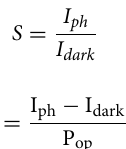
films, the value of the dark current and the photocurrent of ZnO thin films annealed by using the furnace and IR lamp gradually increased during repetitive on and off cycles with the UV light, indicating the poor reproduc- ibility of the photocurrent. The mechanism for the photocurrent rise and decay from the ZnO thin films is as follows. When the ZnO thin film-based UV photodetector is exposed to air in the dark, the oxygen molecules are